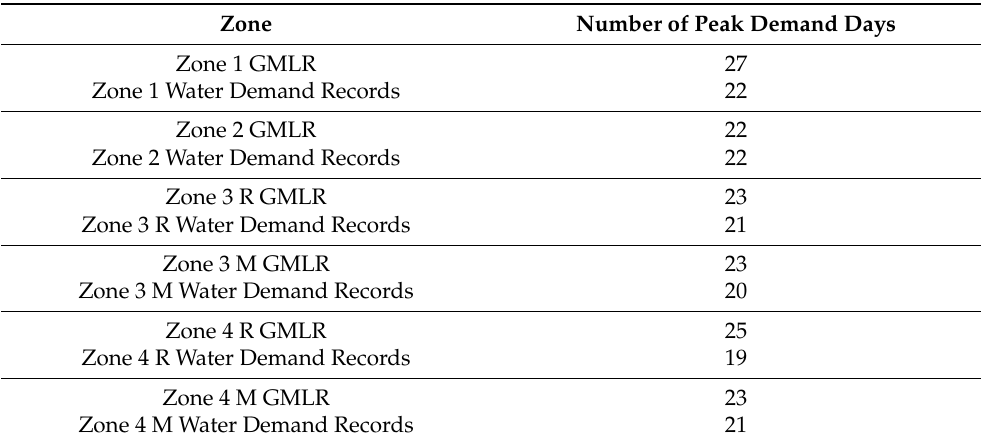
Table 4. Comparison of the mean number of peak water demand days per year between the results from weather data and the water demand records, for the time period